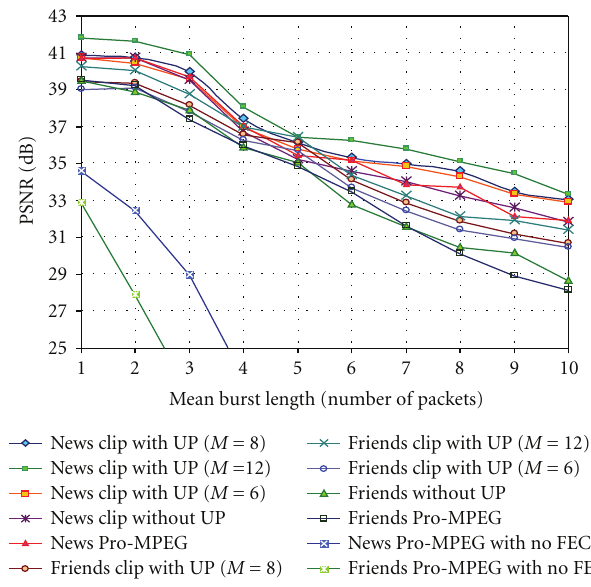
Figure 12: Received video quality with FEC interleaving, with and without priority encoding (marked Unequal Priority (UP)) as well as applying the Pro-MPEG Cop#3r2 interleaving scheme. (Packet type 2DH-5).